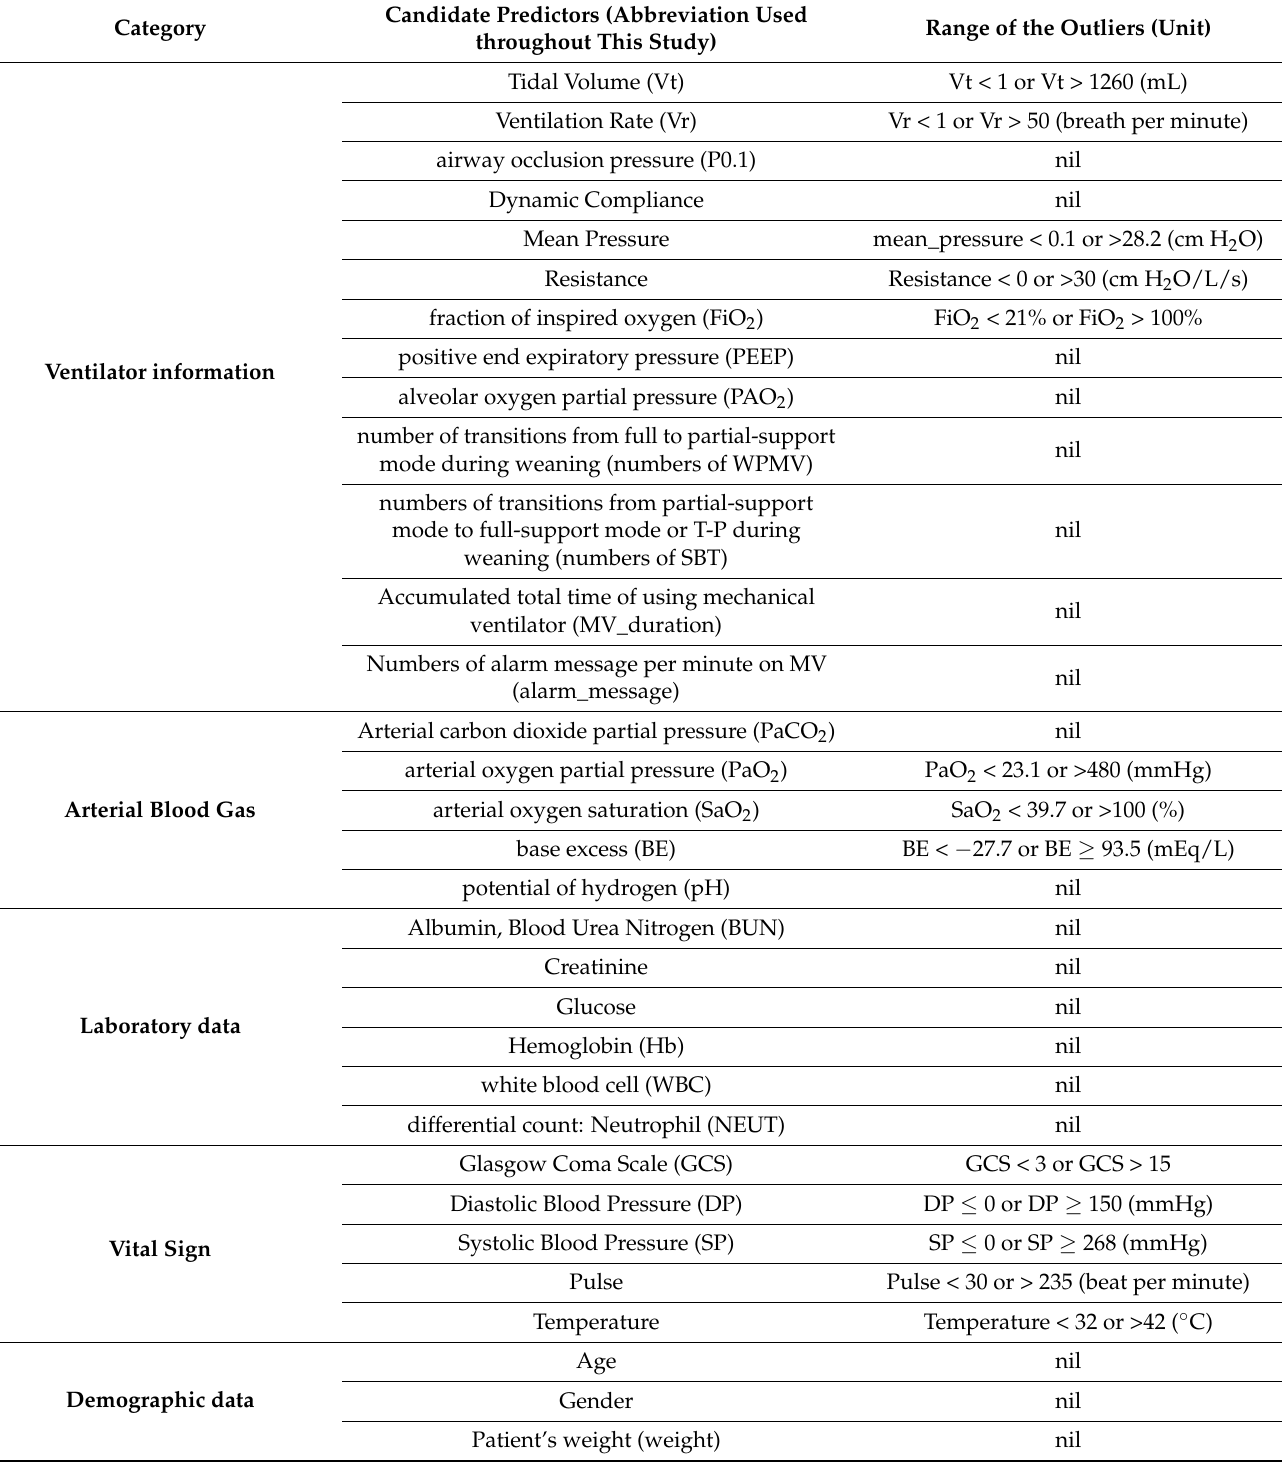
Table 1. List of candidate predictors extracted from the electronic medical